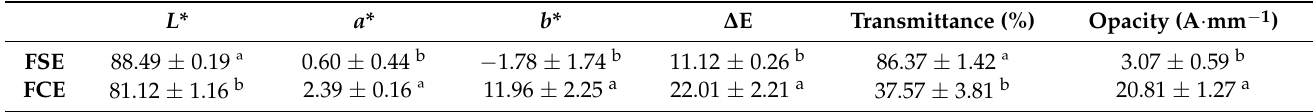
Table 6. Measurement of color, transmittance, and